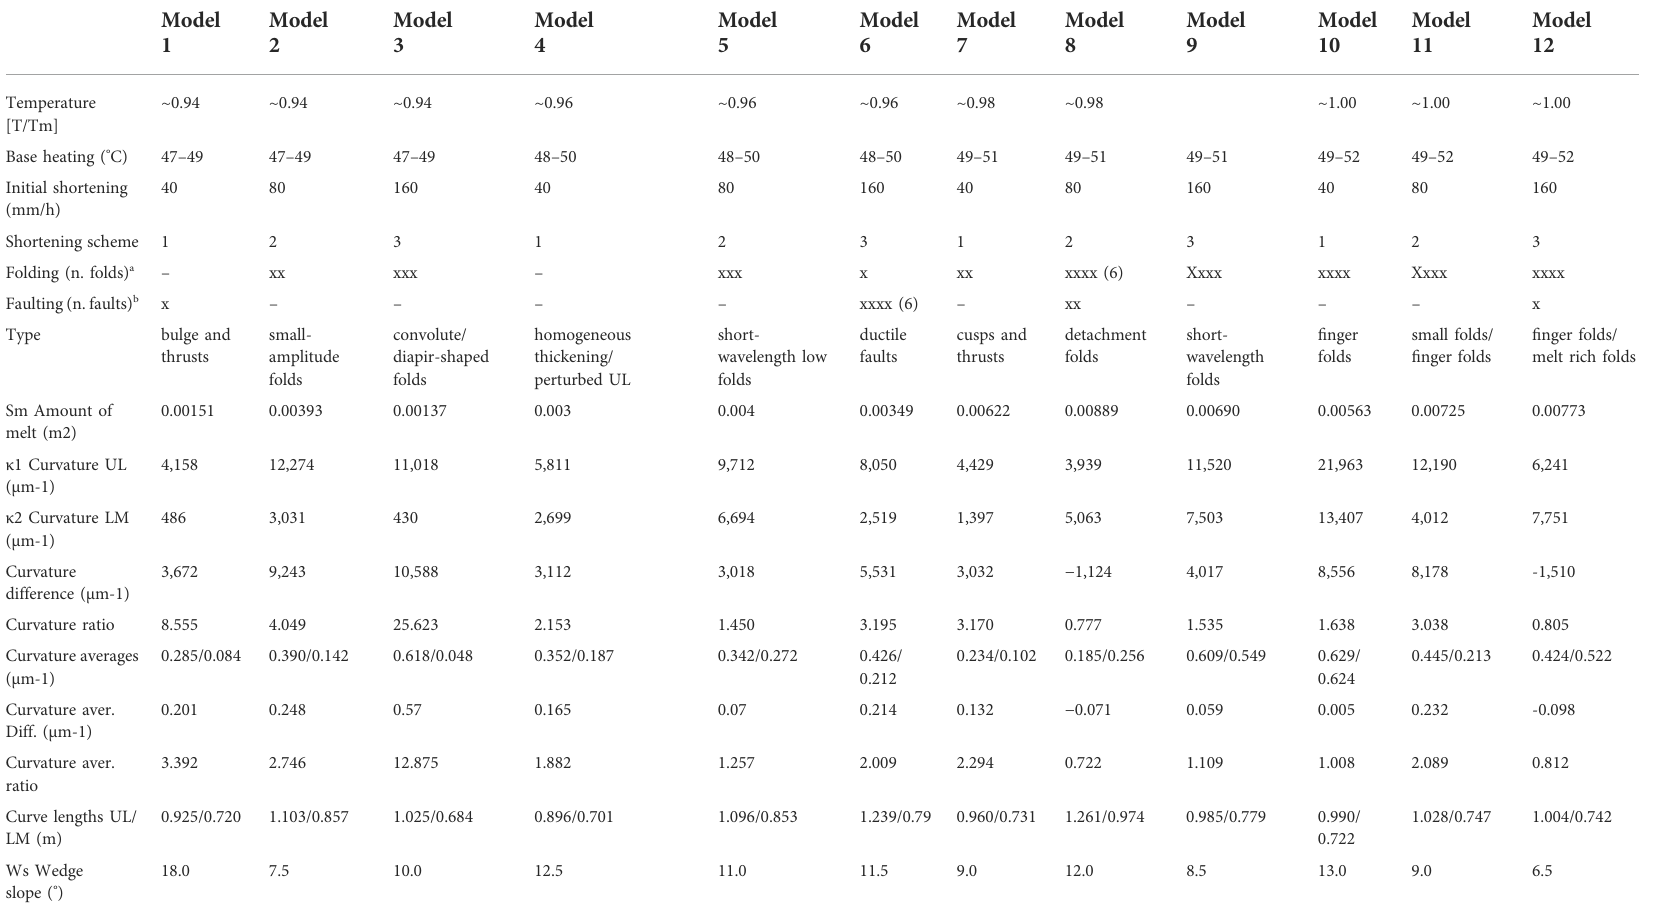
TABLE 2 The quantitative analysis of performed